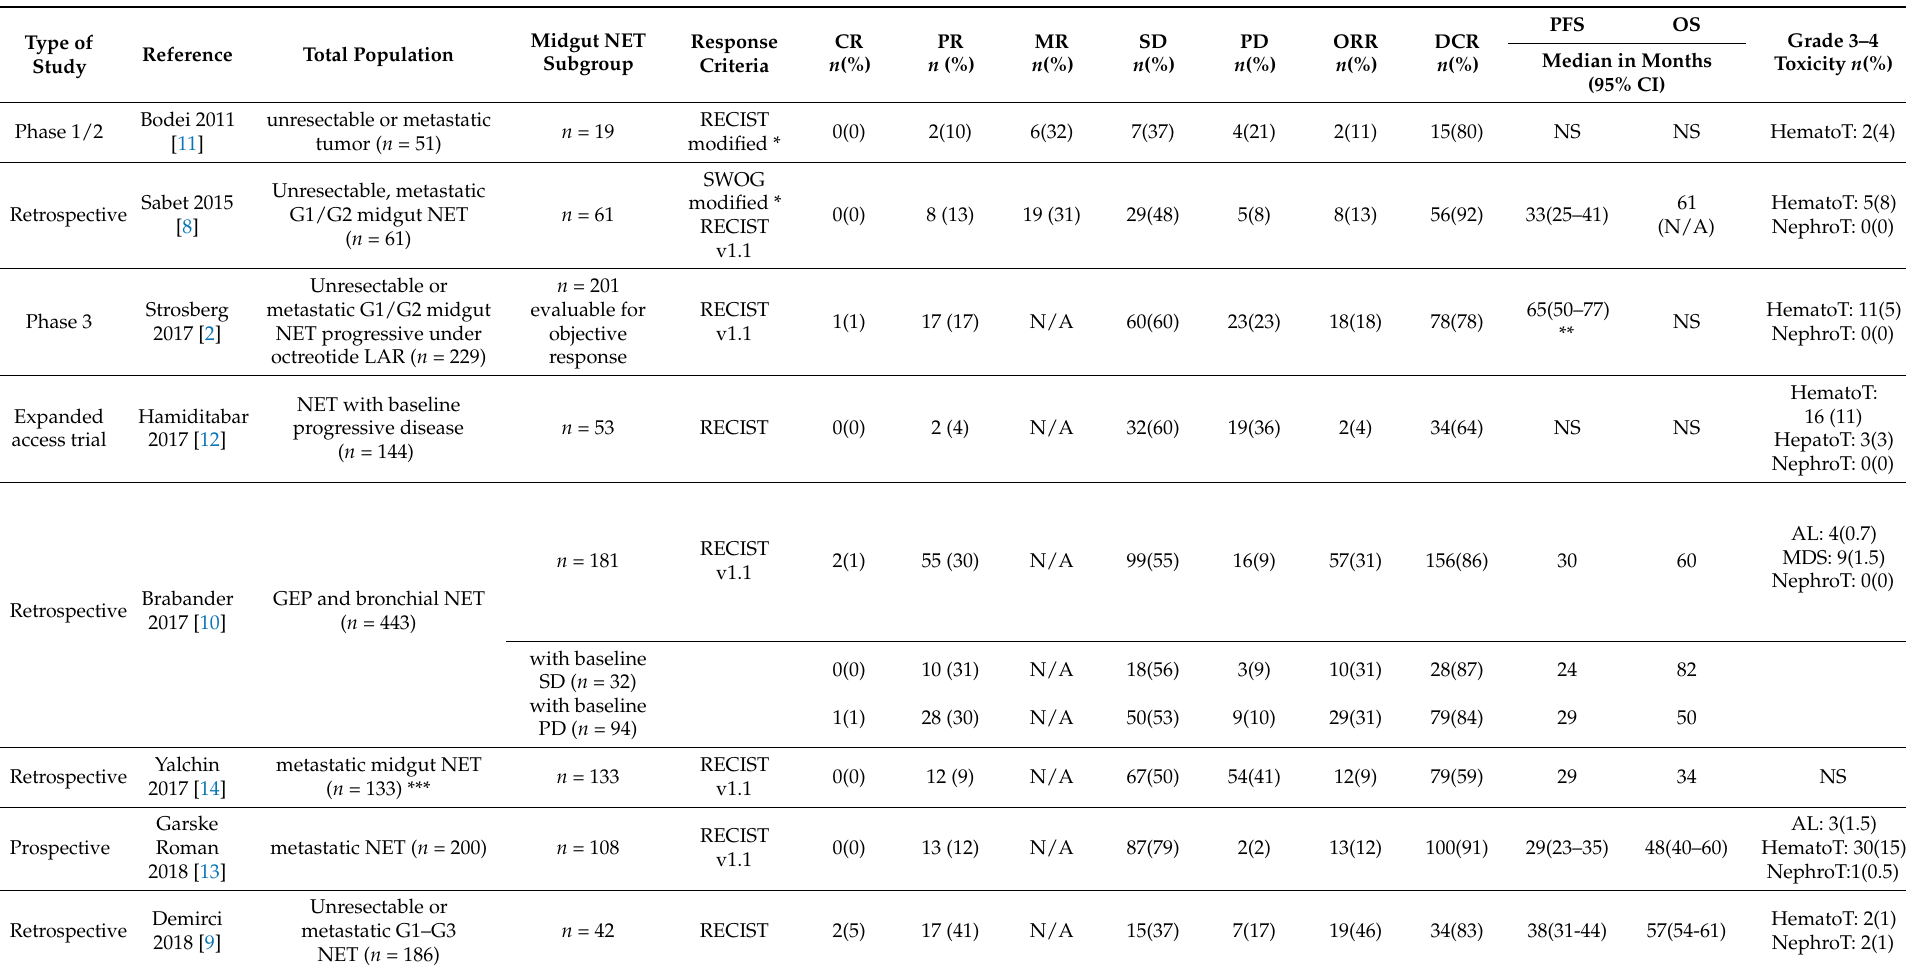
Table 1. Studies reporting 177 Lu-DOTATATE PRRT efficacy and tolerance in midgut